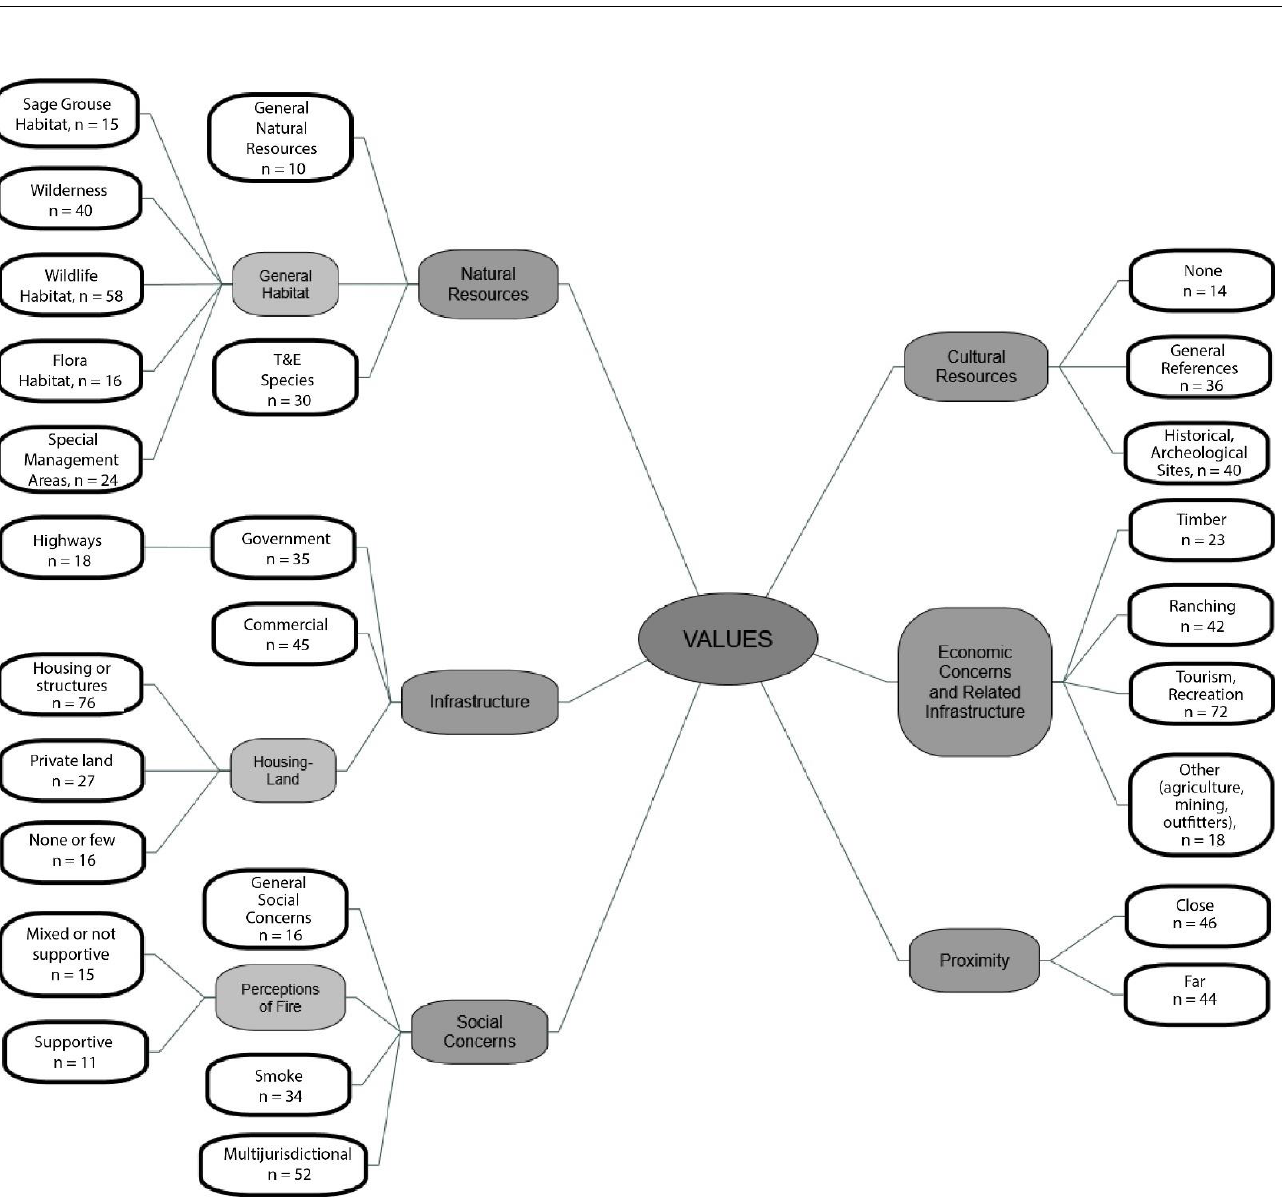
Figure 3. ‘Values at risk’ coding structure that follows the framework of the R elative Risk